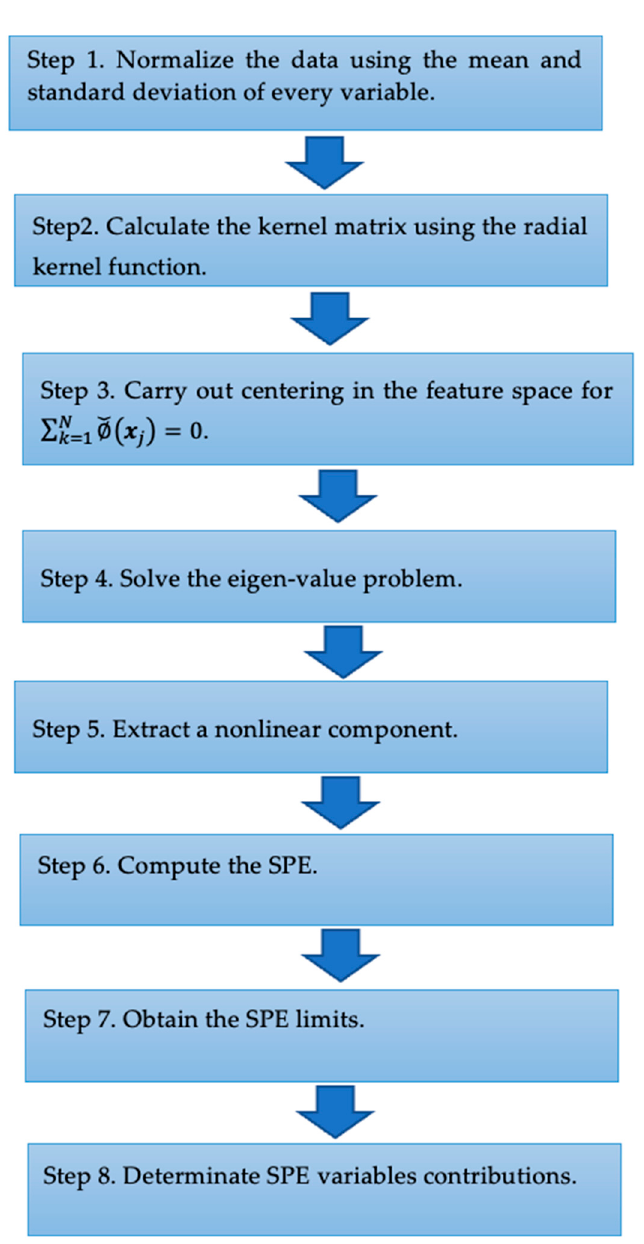
Figure 1. Designed kernel PCA algorithm.